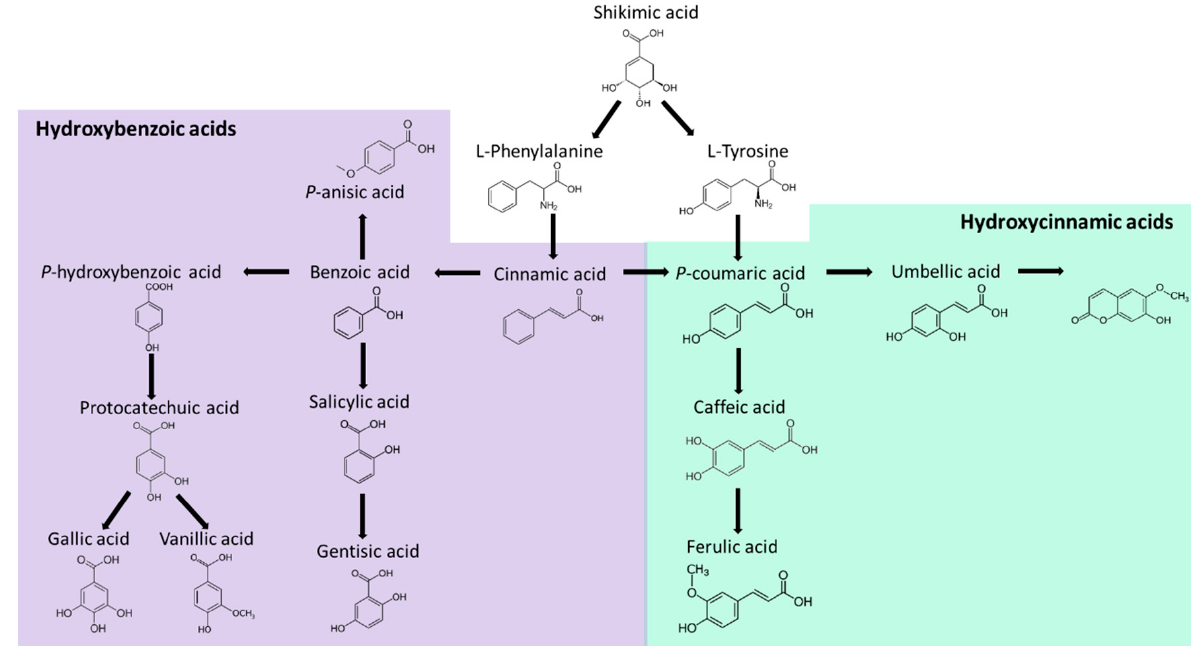
Figure 3. Synthesis of phenolic compounds.